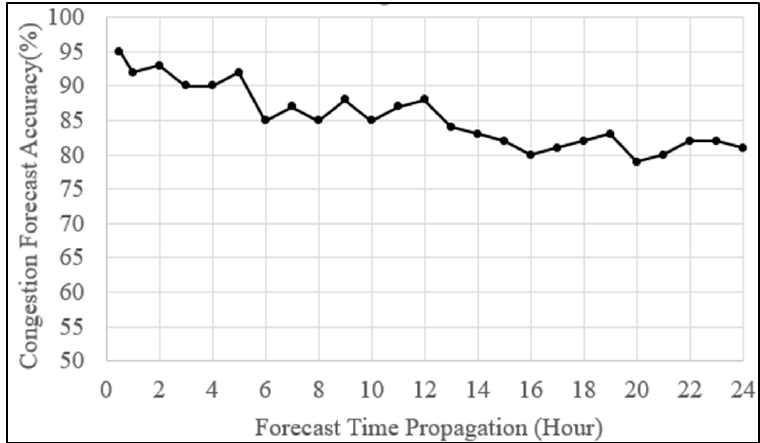
Figure 8. Accuracy variations in the forecast due to time propagation.